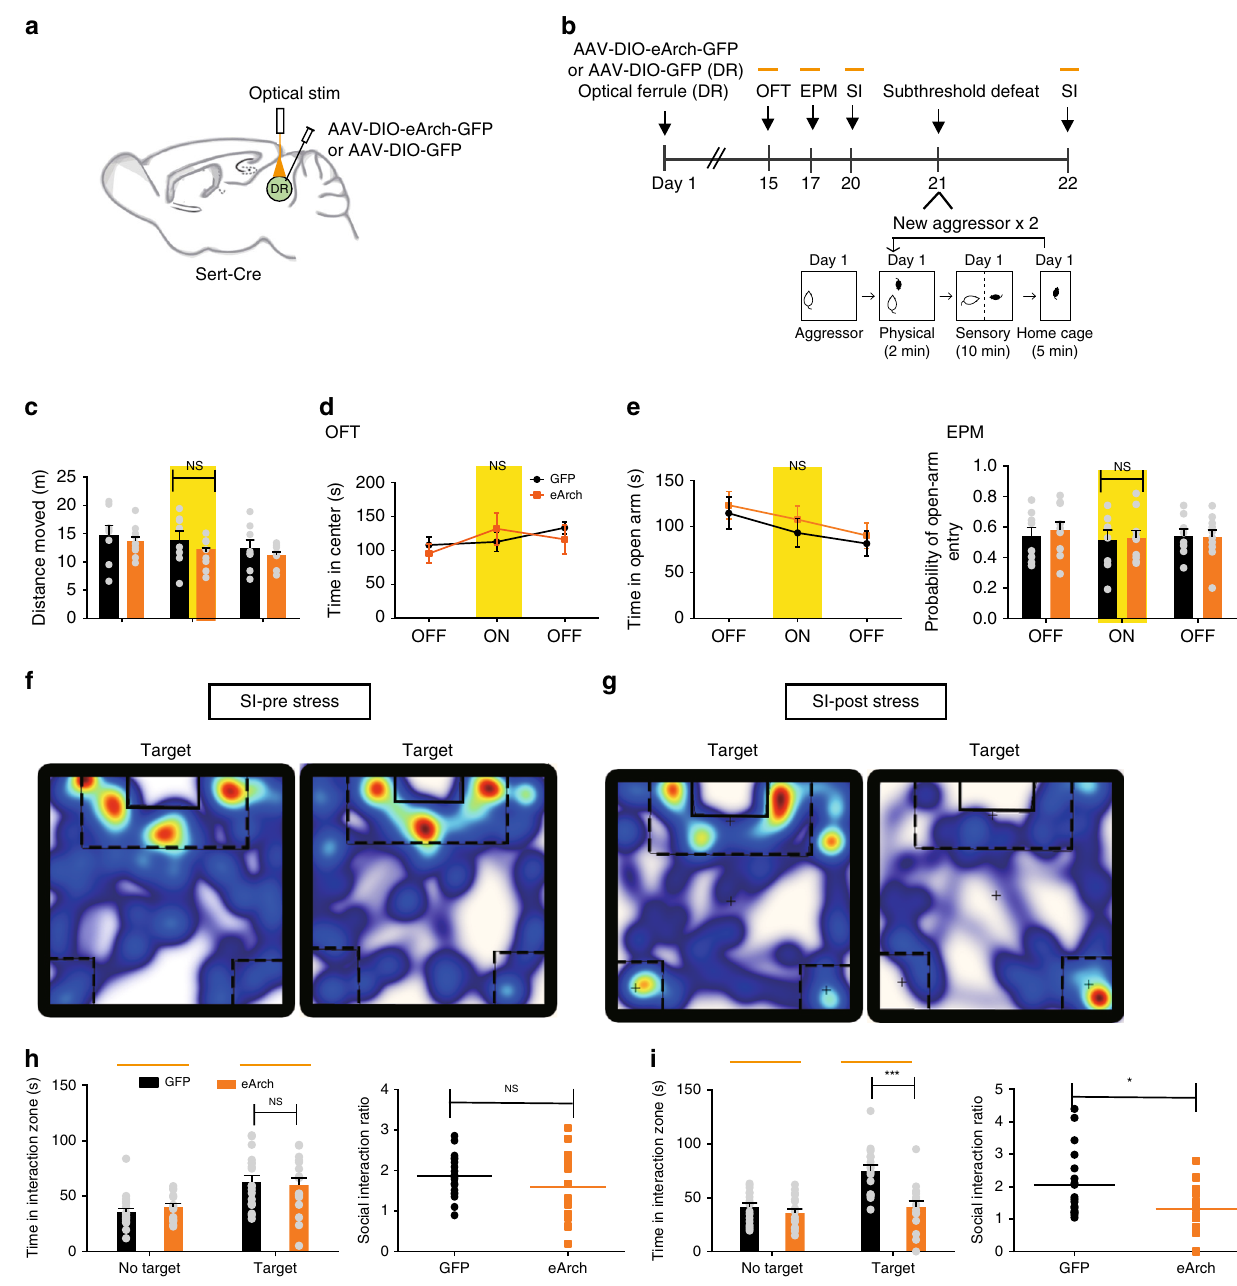
Fig. 4 Silencing of DR 5-HT neurons induces social interaction de fi cits. a Schematic of viral injections and optic fi ber implantations in the DR for optogenetic manipulation. b Experimental timeline of the inhibition of DR serotonergic neurons (top panel). Schematic of the subthreshold paradigm (bottom panel). c – e Silencing of DR serotonergic neurons had no effect on locomotion in the open fi eld test (OFT; eArch, n = 10 mice; GFP, n = 8 mice; one-way ANOVA, F 1,16 = 1.866, P = 0.191) ( c ) or anxiety-like behavior in the OFT (eArch, n = 10 mice; GFP, n = 8 mice; one-way ANOVA, F 1,16 = 0.435, P = 0.519) ( d ), or elevated plus maze (EPM; eArch, n = 10 mice; GFP, n = 8 mice; one-way ANOVA, time: F P = 0.862) ( e ). f , g Representative traces of animals expressing eArch in DR serotonergic neurons during the social interaction test with light stimulation ( f ) or after subthreshold defeat stress with optical stimulation ( g ). Warmer colors indicate more time spent. h No signi fi cant difference was observed for time spent in the interaction zone (eArch, n = 17 mice; GFP, n = 19 mice; one-way ANOVA, F 1,34 = 0.126, P = 0.724) or the social interaction ratio during the silencing of DR 5-HT neurons; (eArch, n = 17 mice; GFP, n = 19 mice; one-way ANOVA, F 1,34 = 1.351, P = 0.253). i Inhibition of DR serotonergic neurons following subthreshold defeat stress exposure elicits social aversion; (eArch, n = 17 mice; GFP, n = 19 mice; one-way ANOVA, interaction: F 1,34 = 20.751, P < 0.001, SI ratio: F 1,34 = 6.037, P = 0.019). Data are represented as mean ± SEM. NS: not statistically signi fi cant; * P < 0.05, *** P < 0.001. Source data are provided as a Source Data fi